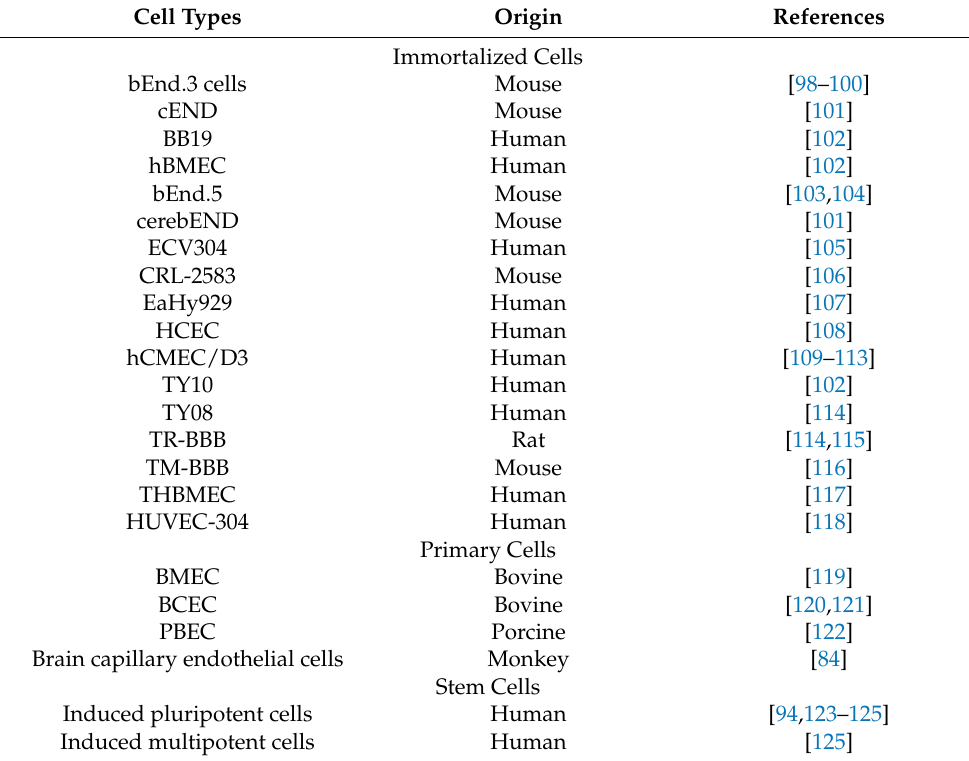
Table 1. Endothelial cells used in in vitro BBB models and their